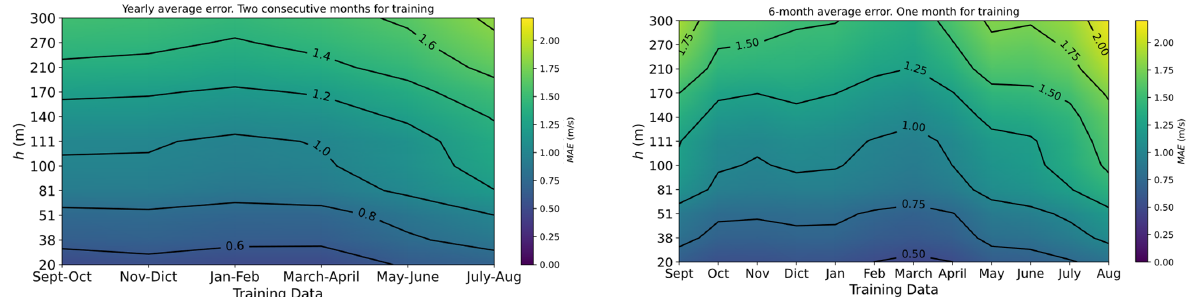
Figure 7. Seasonal effect on the wind speed MAE : ( Left ) regressor is trained with two consecutive months for a year of predictions; ( Right ) regressor is trained with one month for the next six months.